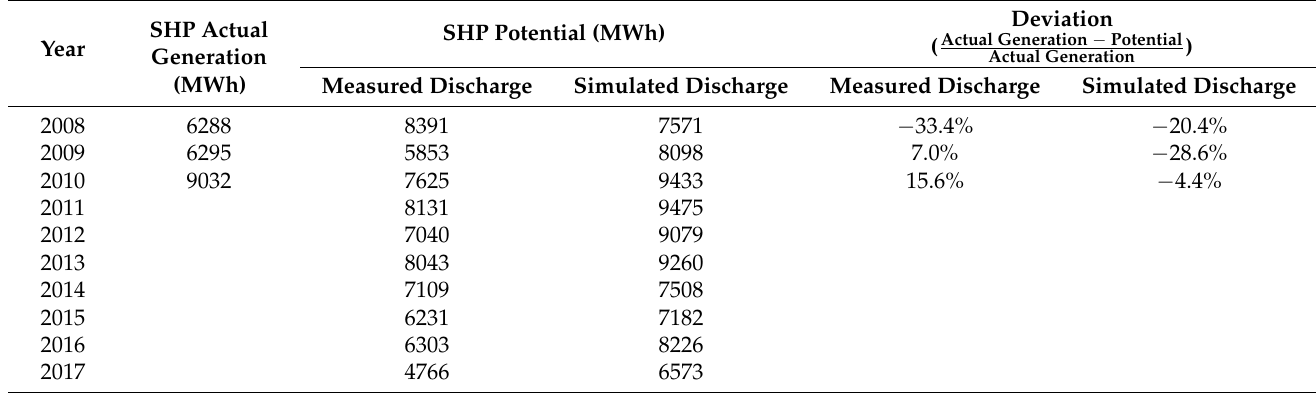
Table 12. Annual SHP potential result for the Deoksong SHP plant.